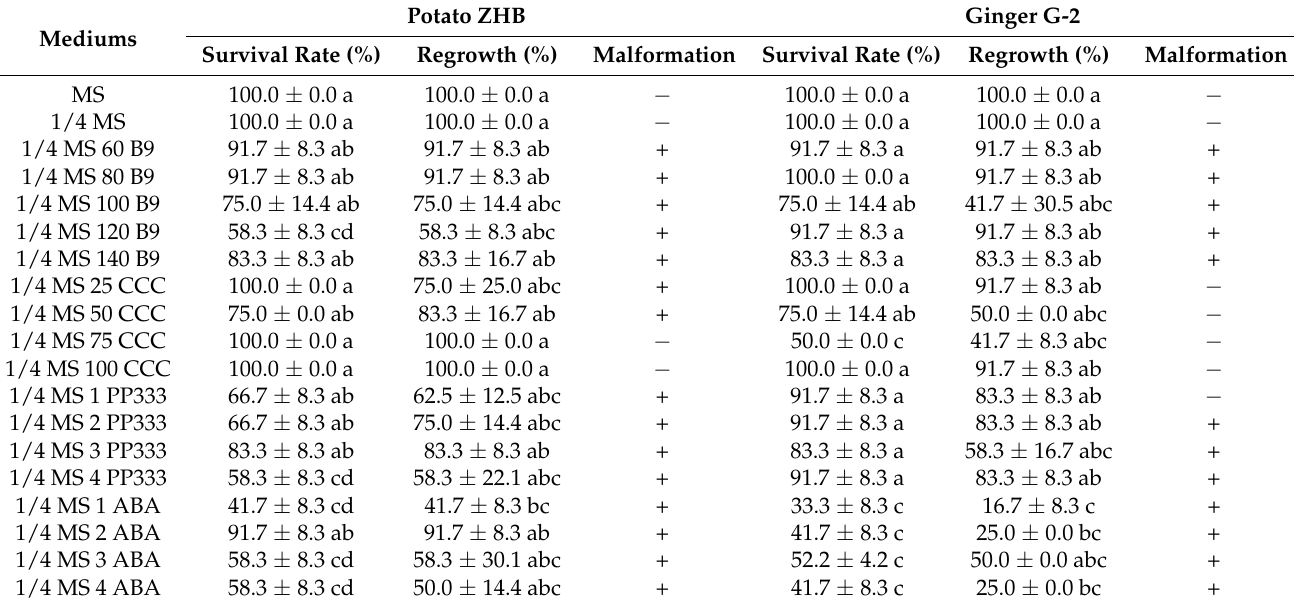
Table 3. Survival and new tissue regrowth of micro-cuttings cultured in different growth media.